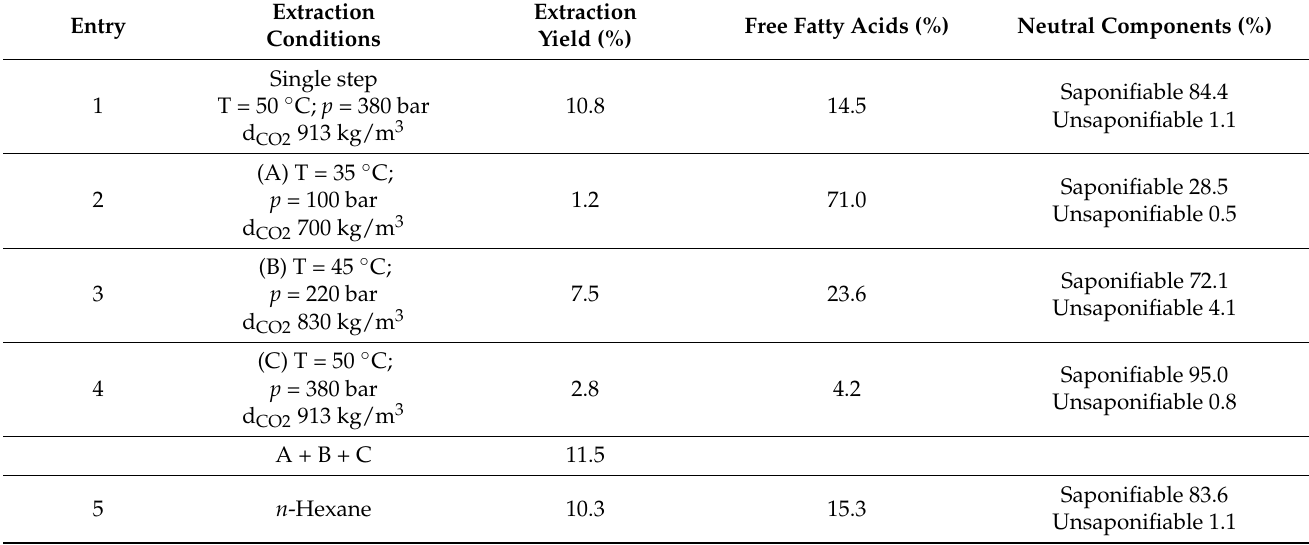
Table 1. Main composition of extracts obtained from Cp seed